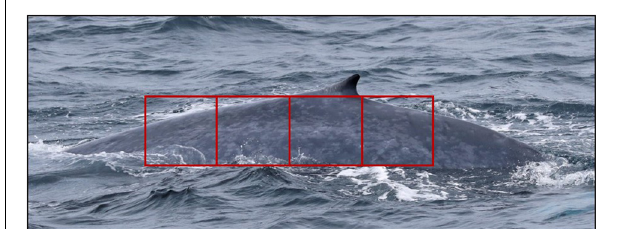
FIGURE 1 | Standardized area for all skin condition assessments. The rectangular assessment area is aligned such that 25% of the total area is caudal to the dorsal fin, and 75% is cranial to the dorsal fin. In this image, 100% of the assessment area is visible.